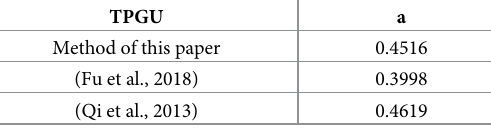
Table 10. Final result data for the three methods. TPGU